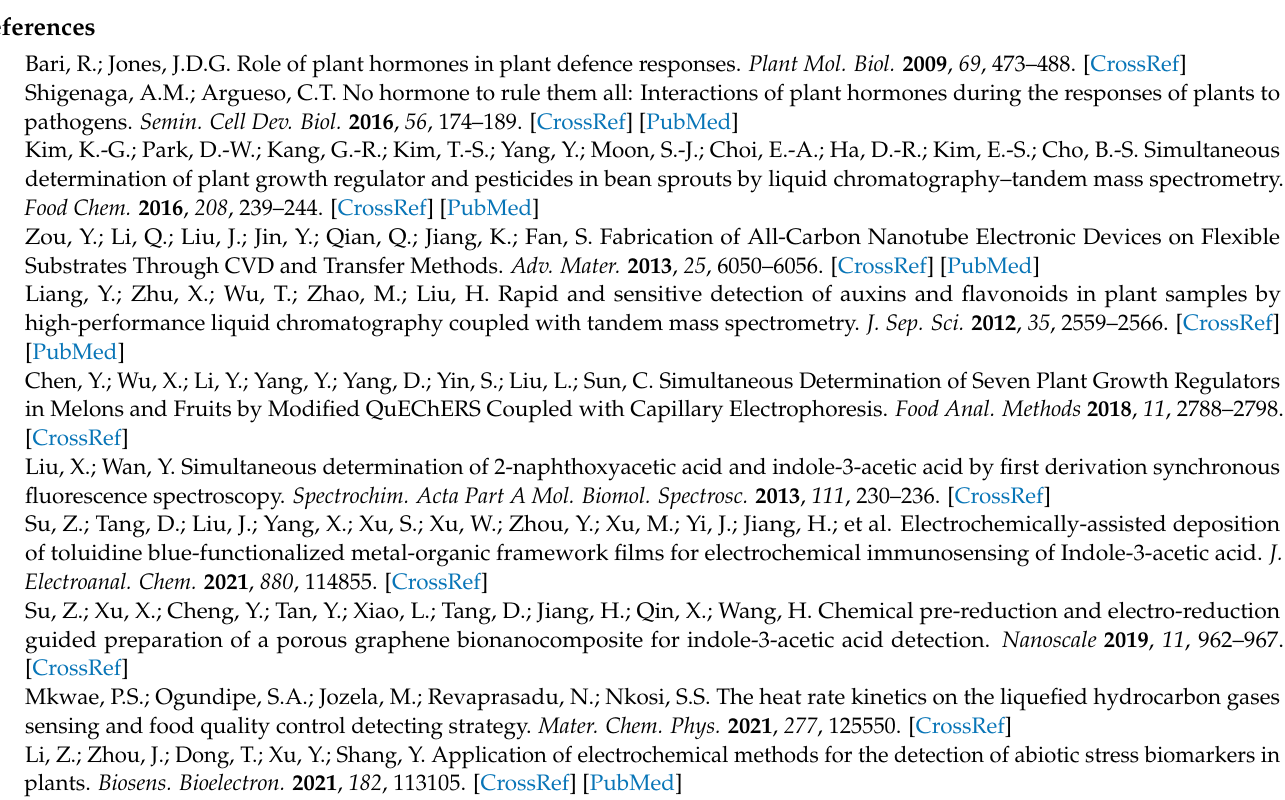
Figure S2: Photographs of unpurified hydrothermal sample (1) and purified hydrothermal sample (2) under UV lamp (365 nm). (b) Excitation and emission spectra of unpurified hydrothermal sample at room temperature. (c) UV-Vis absorption spectrum of unpurified hydrothermal